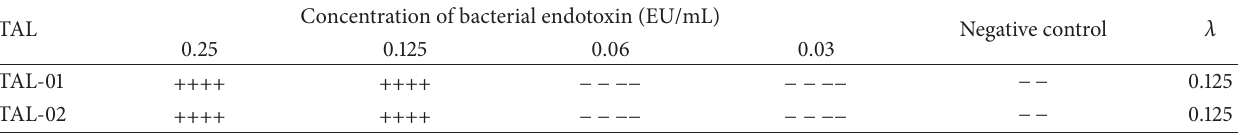
Table 1: The results of confirmation of the labelled sensitivity.